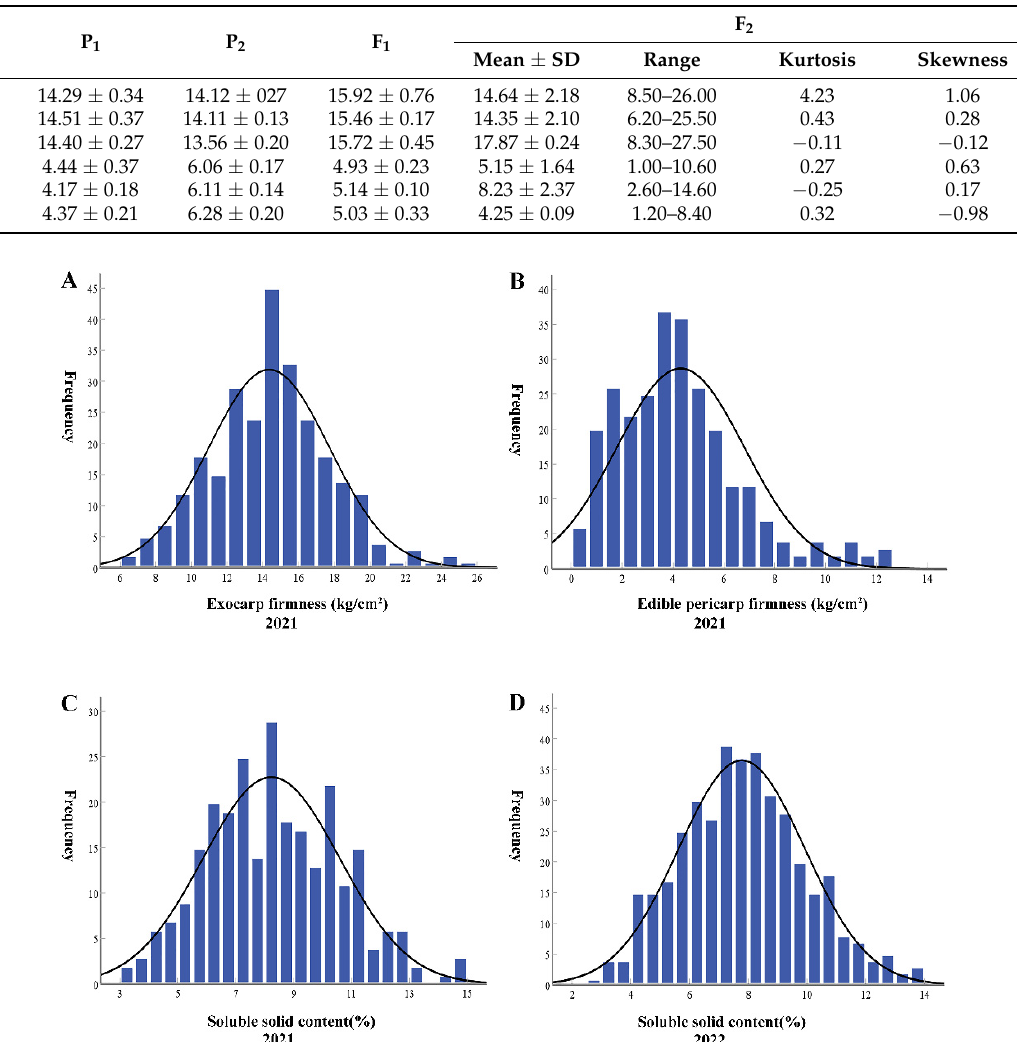
Table 1. Traits data analysis of EF (kg/cm 2 ) and EPF (kg/cm 2 ) in P 1 , P 2 , F 1 and F 2 generations (2018 [29], 2021, 2022).